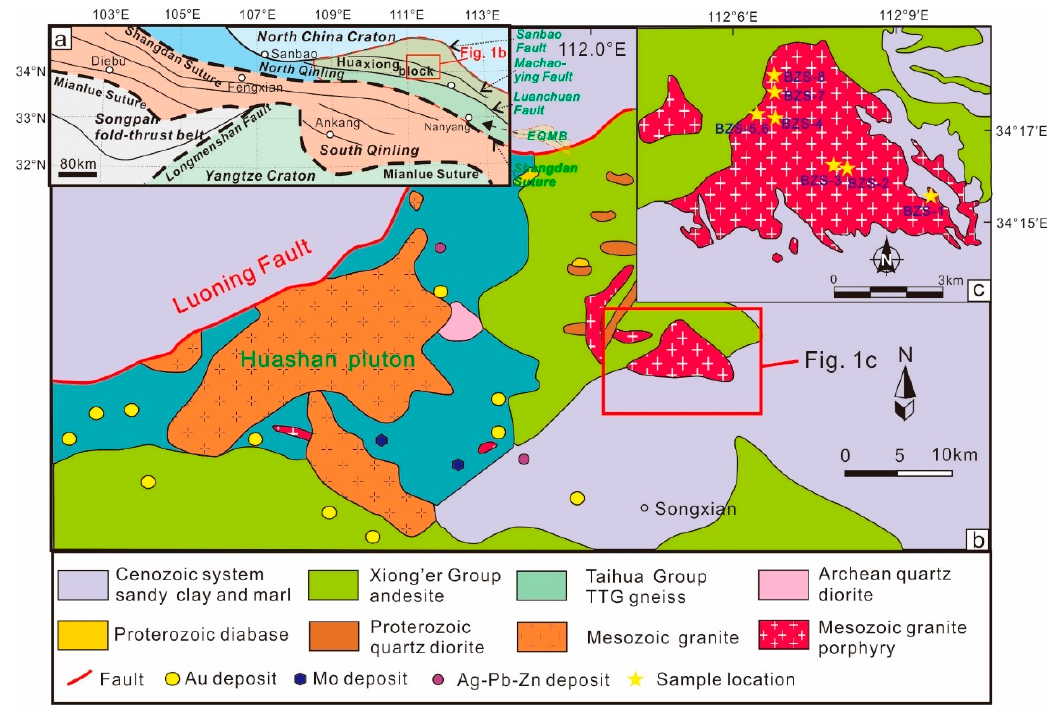
Figure 1. Tectonic framework of the Qinling orogen ( a ), geology and distribution of intrusions in the Xiong’ershan area ( b ) and geological map of the Banzhusi granite porphyry ( c ) (Modified after [17,18,20–24]).